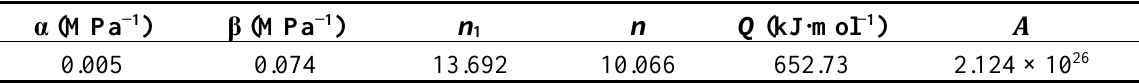
Table 1. The values of all the variables at the true strain of 0.4 for the hyperbolic sine model. α (MPa −1 ) β (MPa −1 ) n n Q (kJ·mol −1 1